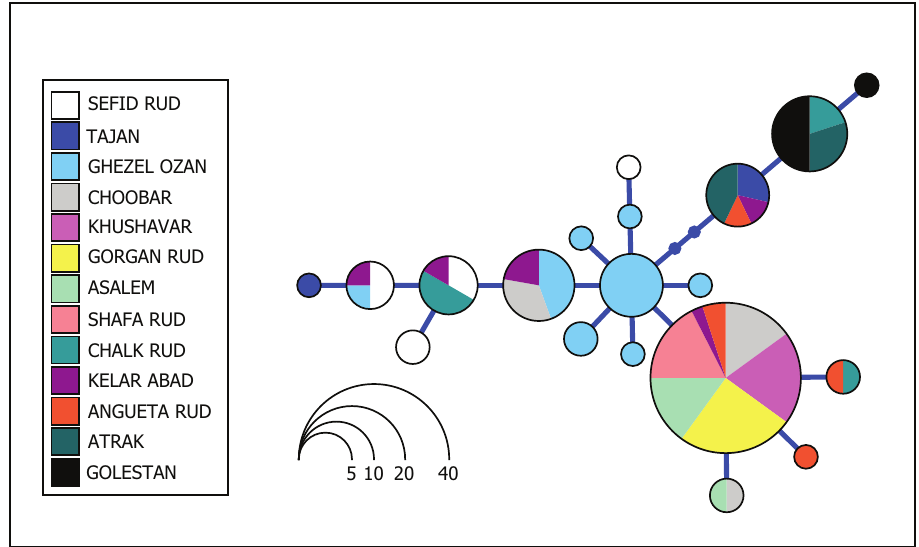
Figure 3. Haplotype networks of available specimens of Caspian Sea basin. Each independent river system is represented by a different colour. Data from Ghanavi et al.